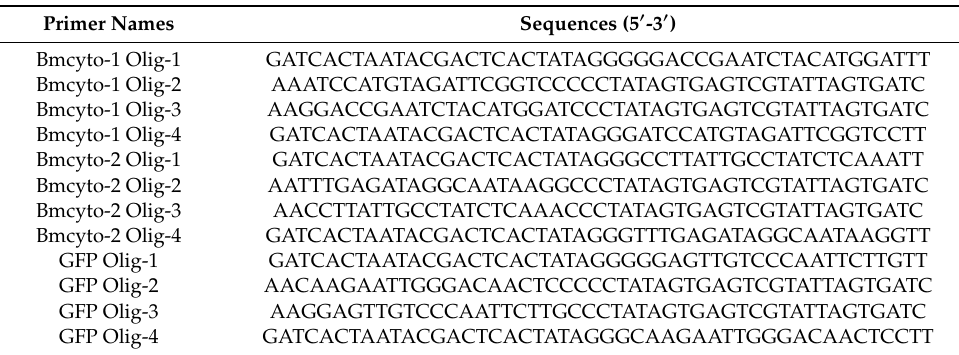
Table 2. Primers used to synthesize